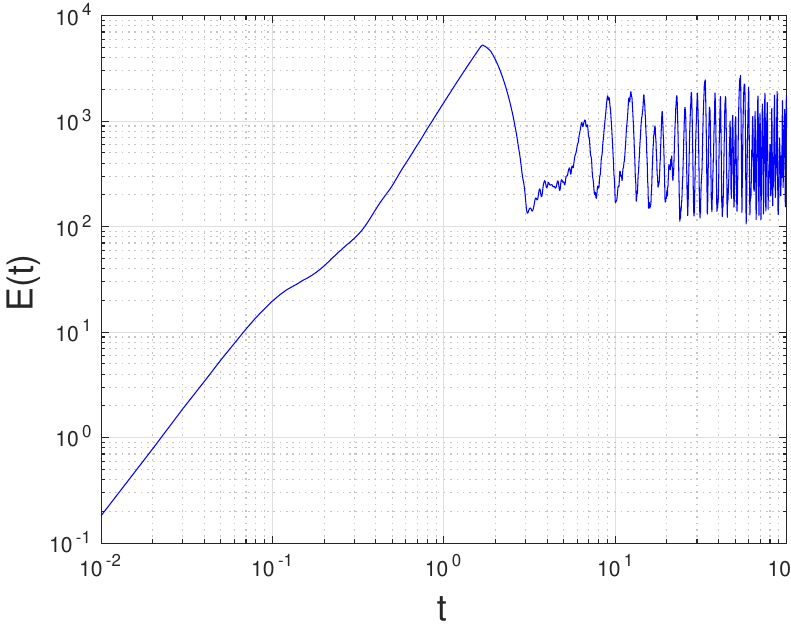
Figure 2. Time evolution of the spatially averaged kinetic energy of the